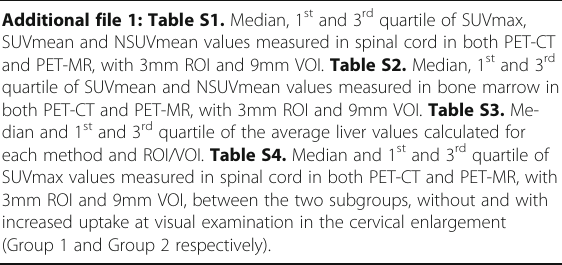
Additional file 1: Table S1. Median, 1 st and 3 rd quartile of SUVmax, SUVmean and NSUVmean values measured in spinal cord in both PET-CT and PET-MR, with 3mm ROI and 9mm VOI. Table S2. Median, 1 st and 3 rd quartile of SUVmean and NSUVmean values measured in bone marrow in both PET-CT and PET-MR, with 3mm ROI and 9mm VOI. Table S3. Me- dian and 1 st and 3 rd quartile of the average liver values calculated